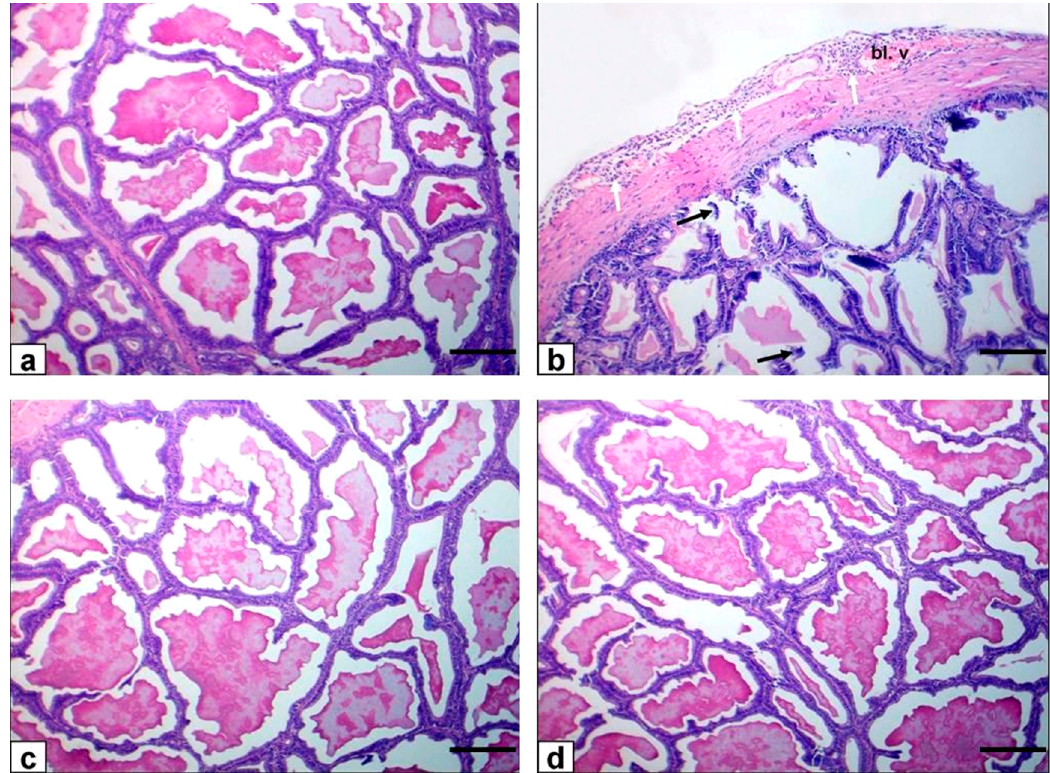
Figure 5. Photomicrograph of rat seminal vesicle stained with HE. Bar = 100 µm). ( a ) The seminal vesicle of the control rats with normal structure and normal luminal secretions. ( b ) FPN-treated rats showing neutrophils, plasma cells, and lymphocytes infiltration in the tunica serosa and the tunica muscularis (white arrows) beside the congestion of blood vessel (Bl. v) and desquamation of some necrotic tubuloalveolar glandular epithelial cells (black arrows) with low luminal secretions. ( c ) FPN + BA 1 rats showing nearly normal histoarchitecture. ( d ) FPN + BA 2 rats showing nearly normal histoarchitecture.